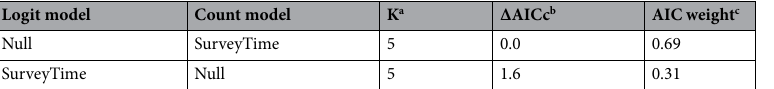
Table 2. Model selection results for analysis of diel variation in non-fatal bird-window collisions. Confidence set models (i.e., those with ΔAICc ≤ 2) resulting from full model selection comparison among candidate zero-inflated Poisson regression models that included factors potentially affecting numbers of non-fatal bird collisions (including stunned birds or birds we observed to collide and then fly away) found in morning, midday, and evening collision surveys in Stillwater, Oklahoma, USA in 2015–2016. Parameters in logit and count models included Season (spring, summer, fall) and SurveyTime (survey start time in decimal format). Weights are based solely on comparison of these models; full model selection results are shown in Supplementary Table S2. a Number of model parameters. b Difference in AICc value between model and top model. c AICc Weight—relative support for